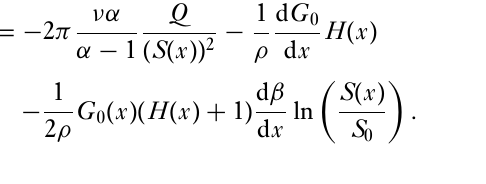
FLOW SIMULATIONS Pressure boundary conditions were set for the inlet at the top of vessel segment 1 and at the outlets at the bottom of segments 4, 5, 6 and 7. Exit pressures were held at 2 kPa for the duration of the flow simulations. This pressure was set to the lower end of the range reported by Defily et al. (1993) for a small epicardial vessel of the same size. Simulations were carried out for two different cases of inlet pressure under unstented and stented conditions: (I) linear increase in inlet pressure from 2 kPa to 3 kPa over 0.25 s and inlet pressure held at 3 kPa up to 1.0 s and (II) a single sinusoidal pressure pulse squared followed by a constant pressure value held at 2 kPa as given by (17).